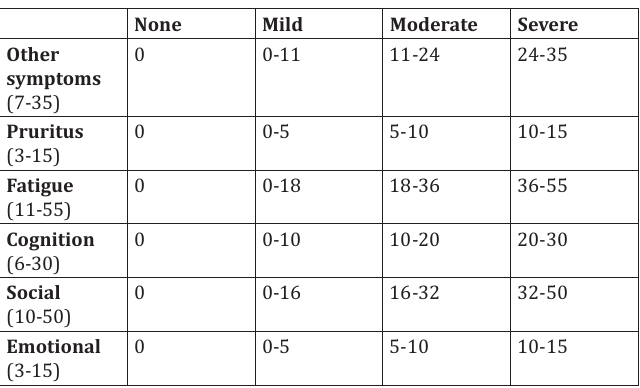
Classification of PBC-40 Field Scores by Severity.